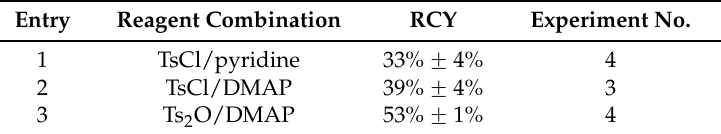
Table 1. Comparison of radiochemical yield (RCY) using different reagent combinations. Entry Reagent Combination RCY Experiment No.